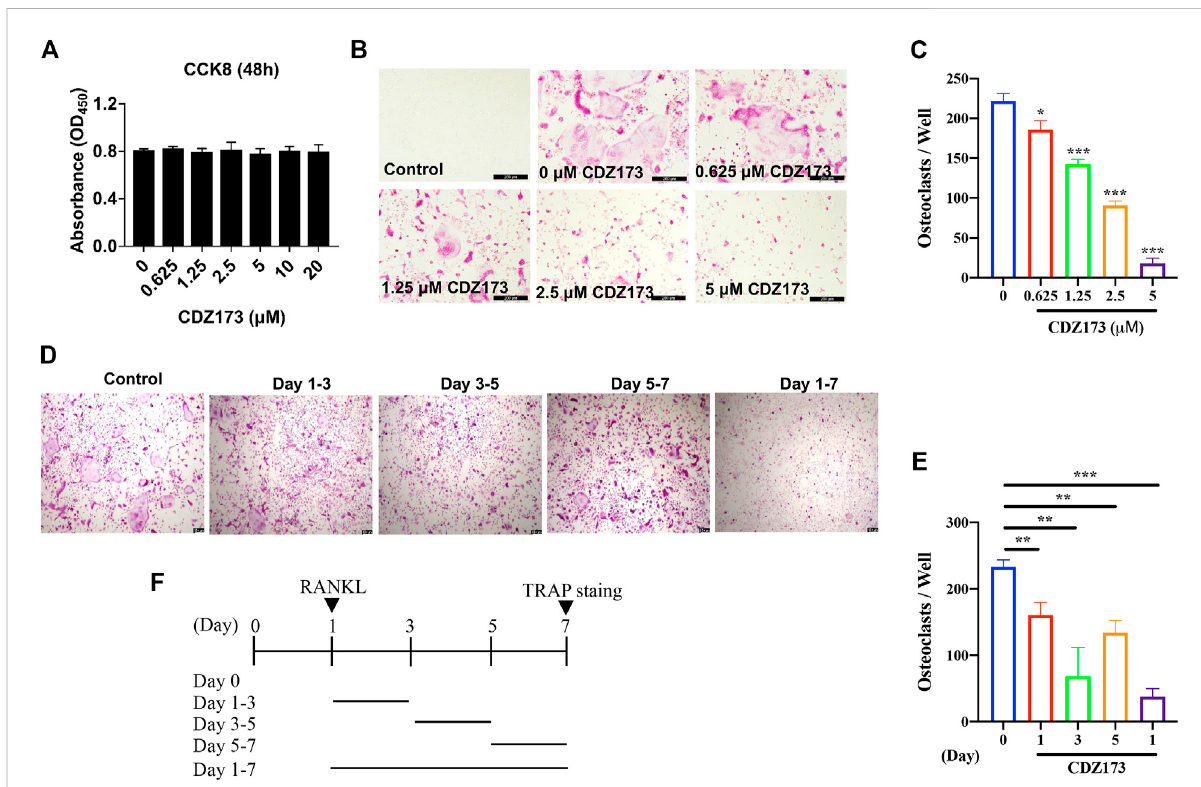
FIGURE 3 CDZ173 inhibited RANKL-induced OC formation without cytotoxic effects in vitro . (A) BMMs were treated with indicated concentrations of CDZ173 for 48 hand tested byCCK-8 assays. (B) BMMsweregiventherelevant doses ofCDZ173,M-CSF(30 ng/ml), andRANKL (30 ng/ml) overthe courseof5 days.Afterthat,thecellswerestainedforTRAPafterbeing fi xedwith4%paraformaldehyde(scalebar=200 µM). (C) ThenumberofTRAP positive multinucleated OC (nuclei > 3) were quanti fi ed (n = 3). (D – F) TRAP positive BMMs after the treatment with 5 µM CDZ173 for